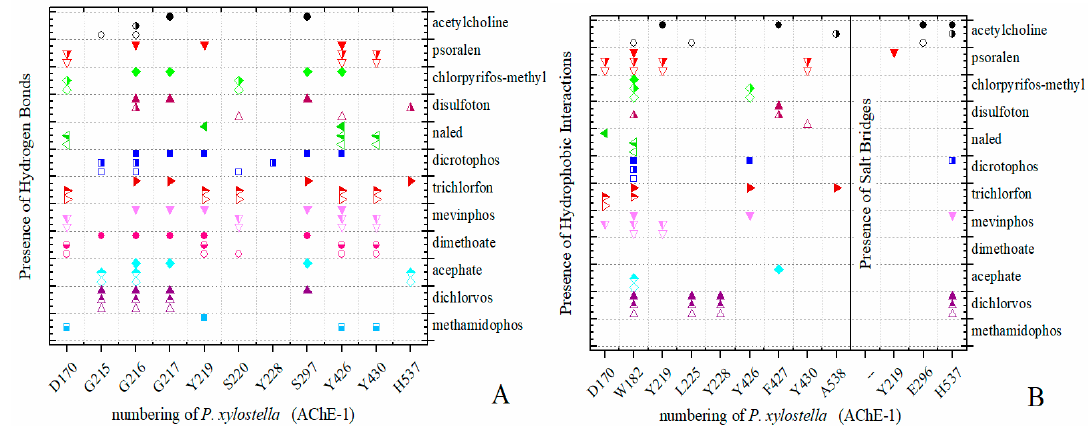
Figure 5. PLIP (Protein-Ligand Interaction Profiler) results in AChE-1 of P. xylostella . Identification of noncovalent interactions; ( A ) hydrogen bonds, ( B ) hydrophobic interactions and salt bridges. Full symbol, AChE-1 wild type; empty symbol, modified AChE-1 by A201S and G227A; half full symbol, modified AChE-1 by A201S, G227A, and F290A.